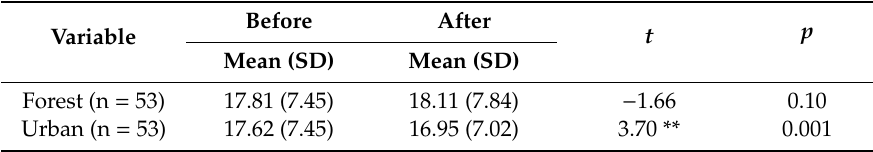
Table 6. Changes in vitamin D levels before and after forest therapy.